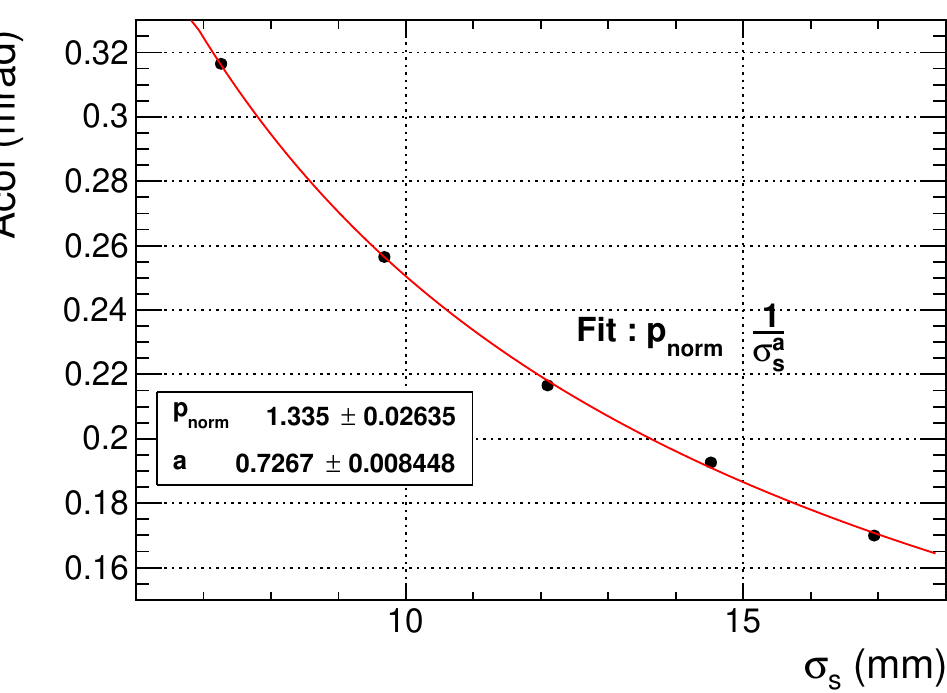
Figure 13 . The acollinearity variable as a function of the longitudinal length of the bunch, as determined from Guinea-Pig , for leading-order Bhabha events. The curve shows the result of a (cid:12)t to a power